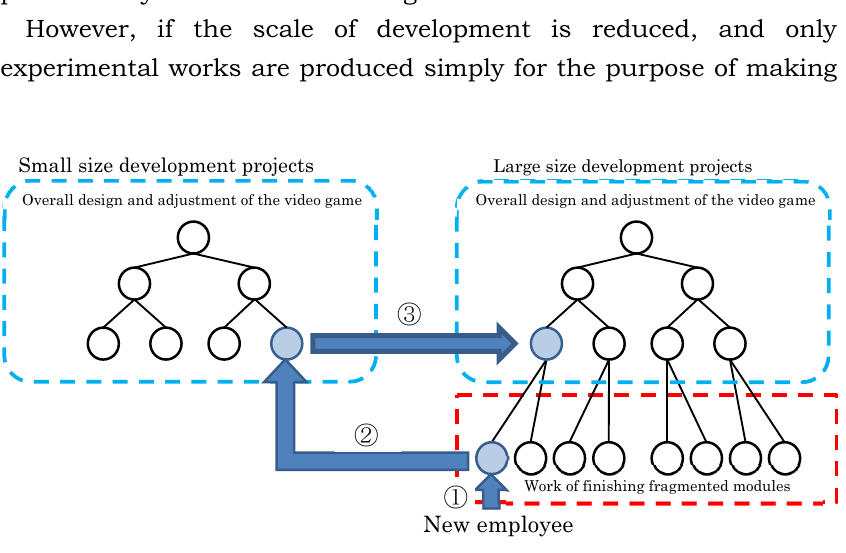
Figure 2. Human resource development using a small development